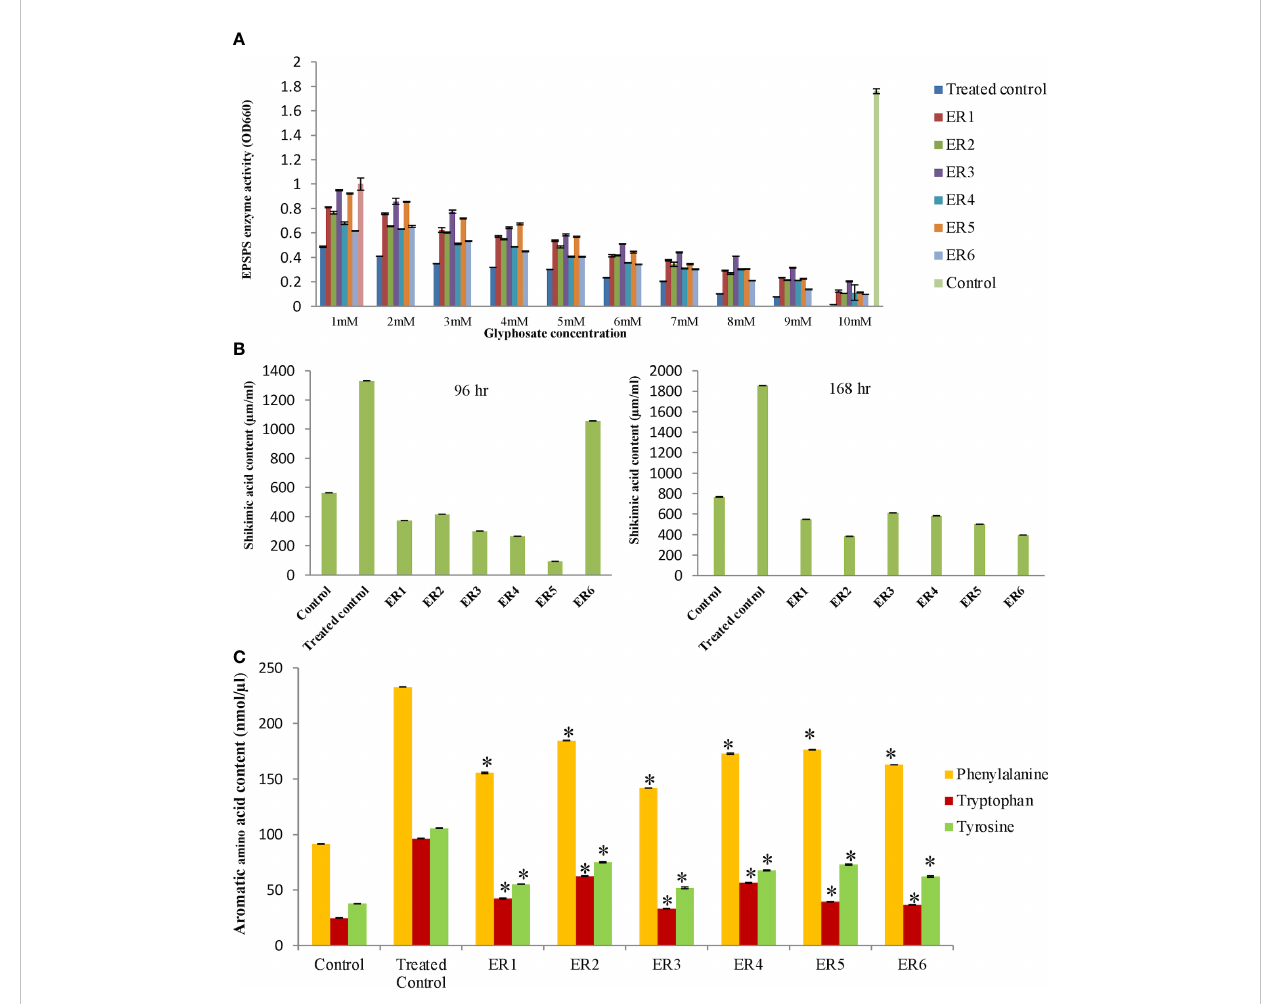
FIGURE 6 Quanti fi cation of shikimic acid and aromatic amino acid in rice edited plants. (A) EPSPS enzyme assay of rice edited plants. Experiment was performed with crude protein extract from edited along with wild-type plants by measuring inorganic phosphate release. Graph was plotted with absorbance measured at OD660. Data represent the mean ± SE of three independent experiments (n = 3), P ≤ 0.05. (B) The graphical presentation of shikimic acid content accumulation in edited lines and WT plants by HPLC method. The shikimic acid level was quanti fi ed after 96 and 168 h of GT (6 ml/L). Data represent the mean ± SE of three independent experiments (n = 3), P ≤ 0.05. (C) The graphical presentation of aromatic amino acid content in rice edited lines. The effect of glyphosate on the abundance of amino acids (Phe, Trp, and Tyr) was quanti fi ed after 96 h of glyphosate treatment (6 ml/L). Data represent the mean ± SE of three independent experiments (n = 3), P< 0.05. The statistical signi fi cance was tested using one way ANOVA (P ≤ 0.05) followed by Tukey HSD test (HSD0.5). Asterisk (*) indicates that values of edited lines are signi fi cantly different in relation with WT at P ≤ 0.05 according to the ANOVA